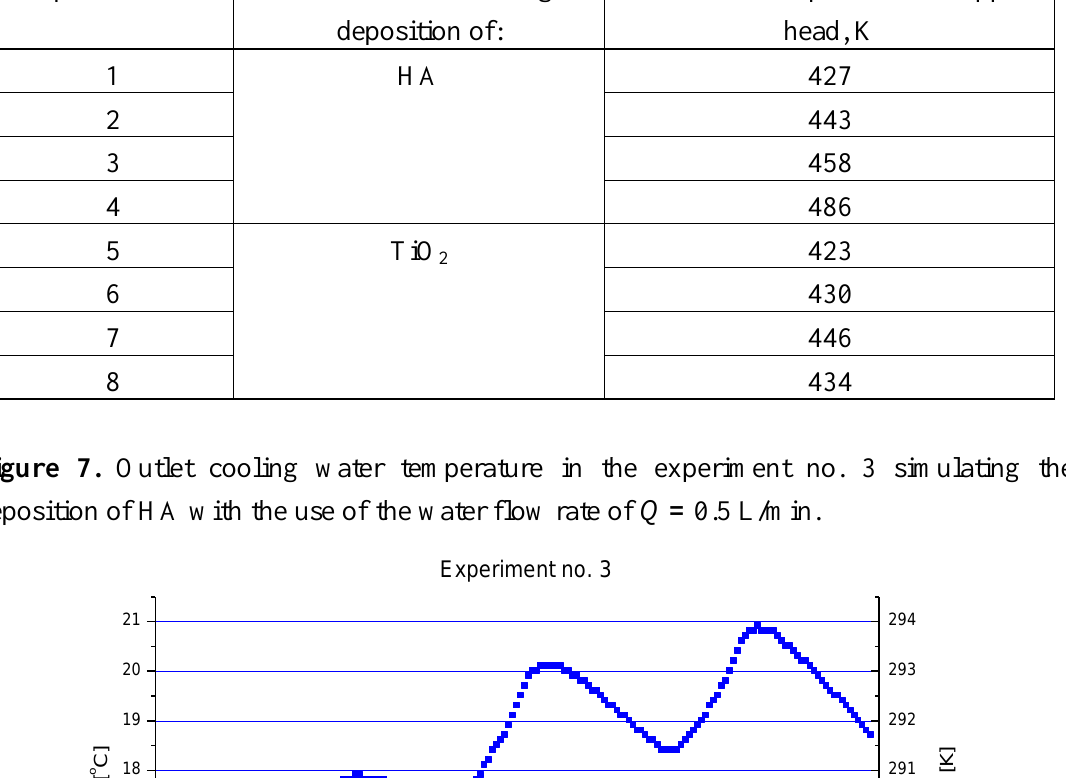
Table 4. Temperatures of the copper head during the calorimetric heat flux measurements. Experiment no.